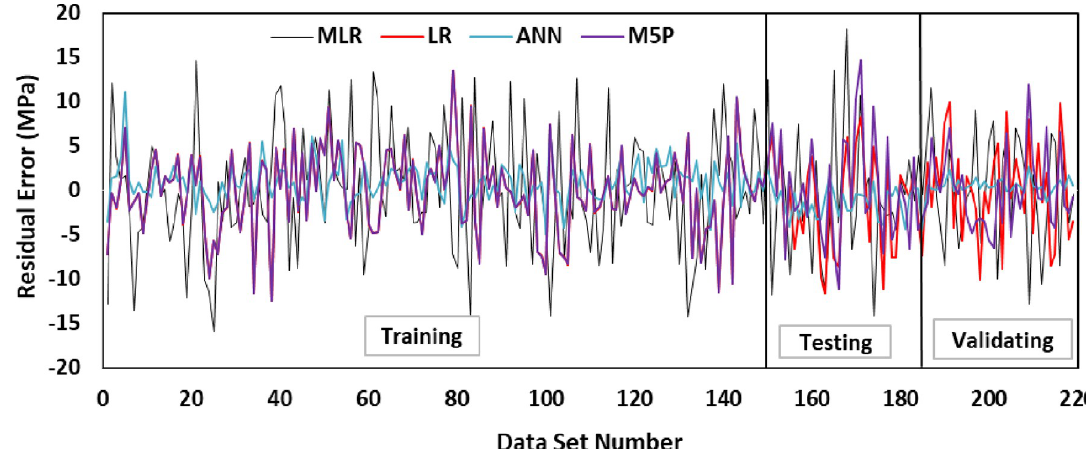
Fig 19. Relationship between Residual error and compressive strength of GGBS/FA-GPC mixtures.